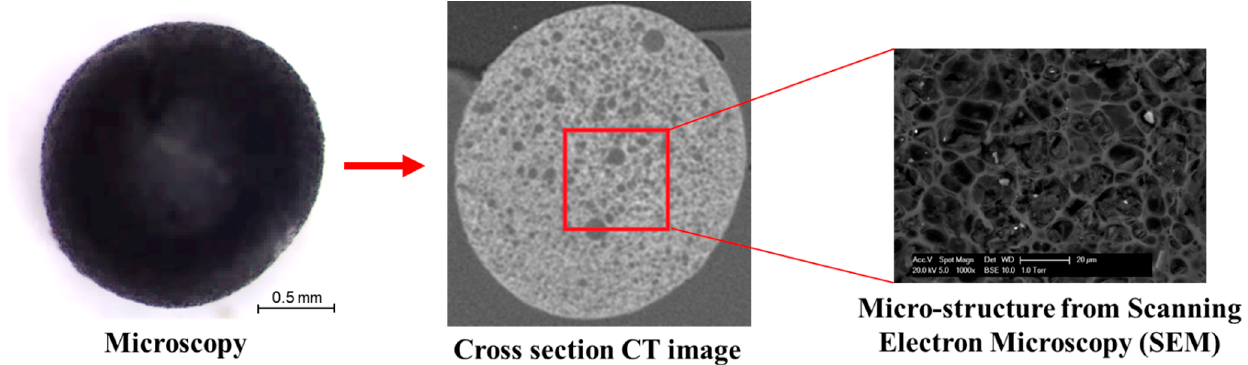
Figure 4. Images of a single calcium alginate capsule. Reproduced with permission from refs. [24,26]. Copyright 2018 Elsevier Ltd.